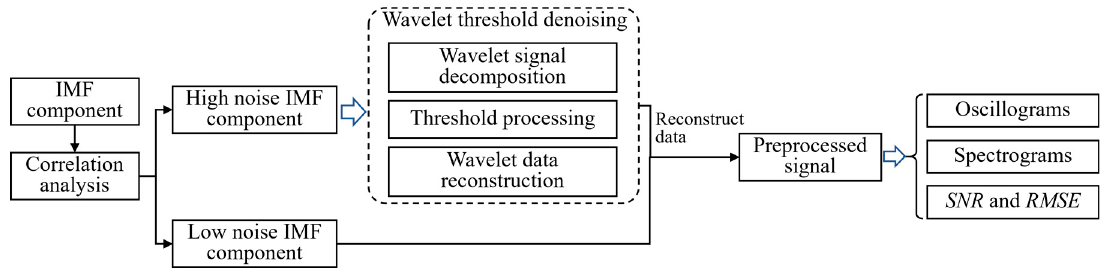
Figure 7. Flow chart of wavelet threshold denoising.